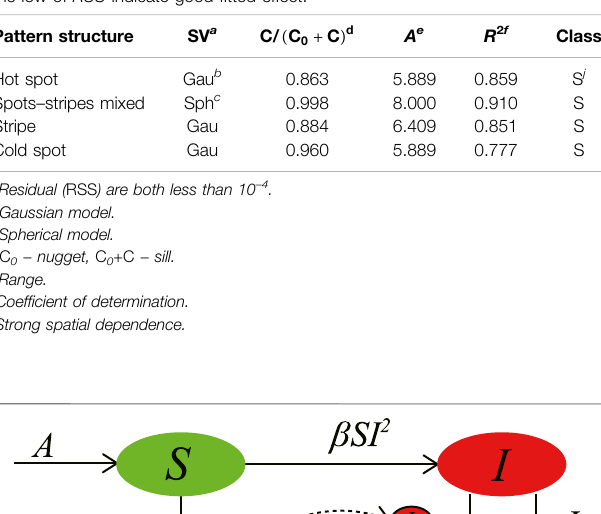
TABLE 2 | Fitted semivariogram models (SV) and their characteristic parameters for different vegetation pattern structures ( Figure 3 ). The high value of R 2 and the low of RSS indicate good fi tted effect.